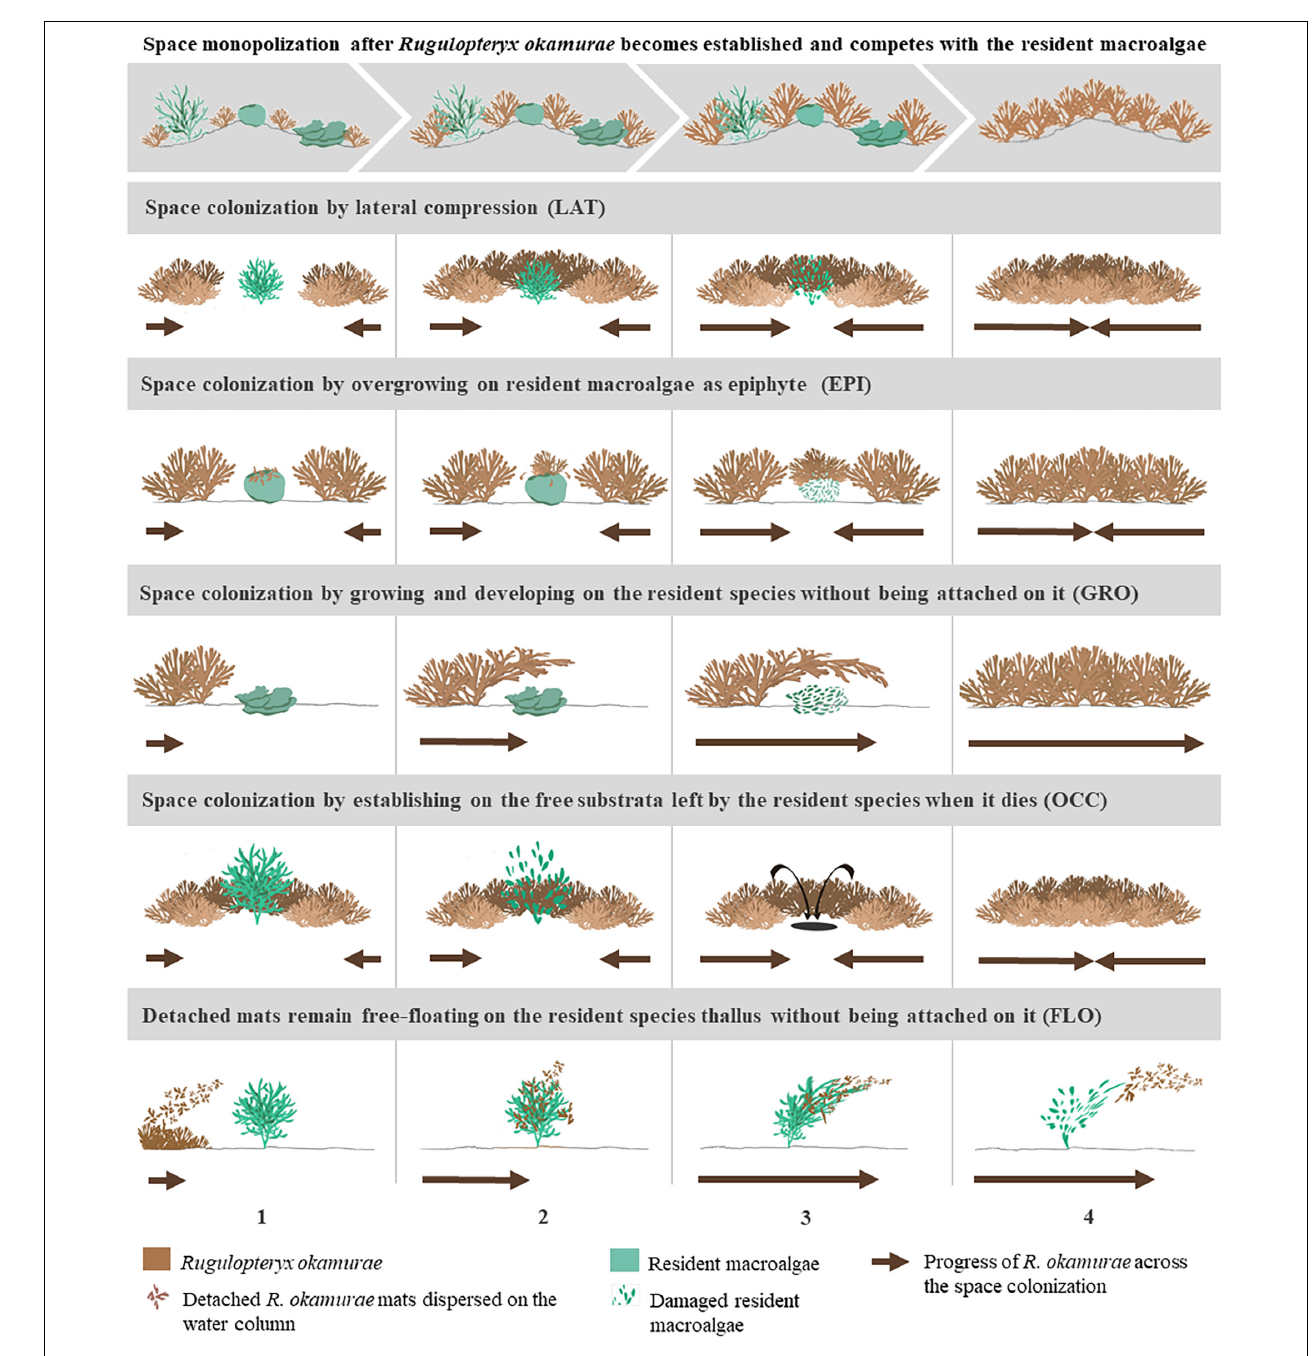
FIGURE 3 | llustrative diagram showing space colonization strategies described between R. okamurae and resident marine macroalgae and subsequent implications in generally illuminated rocky bottoms of the Strait of Gibraltar. Numbers represent the sequential stages of the